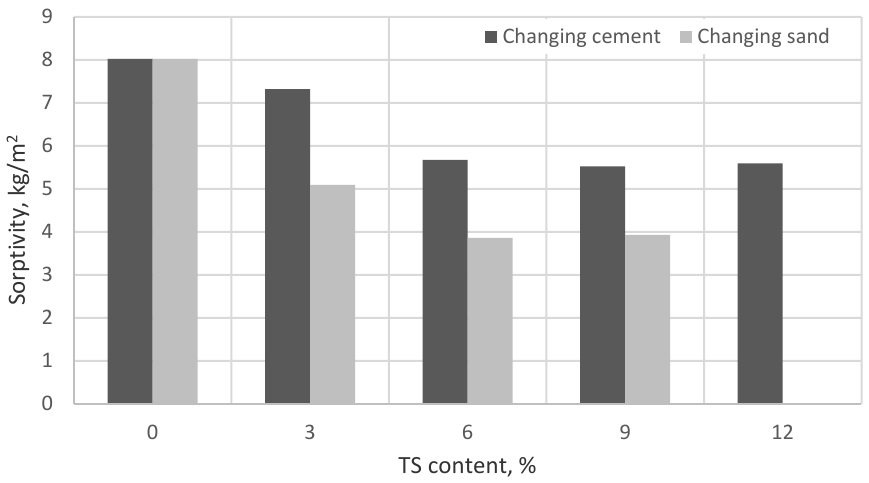
Figure 11. The impact of TS on the sorptivity in mortars used for renovation application.